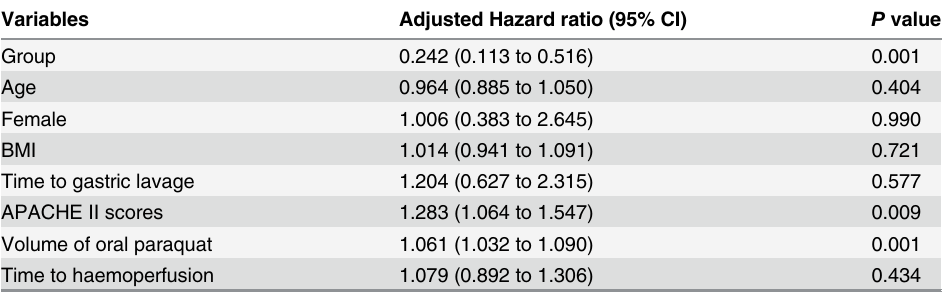
Table 3. Significant risk factors for mortality among patients with paraquat poisoning.